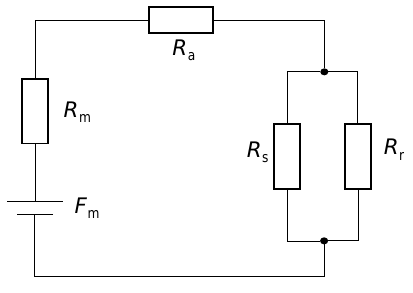
( b ) Figure 12. Effect of changing ring thickness ( N = 30,000 rpm, P o = 500 W): ( a ) torque constant and magnet eddy current loss and ( b ) motor efficiency. ( a ) ( b ) Figure 13. Effect of changing ring relative permeability ( N = 30,000 rpm, P o = 500 W): ( a ) torque constant and magnet eddy current loss and ( b ) motor efficiency. 4.2. Magnteic Circuit The simulation results in Section 4.1 are analyzed by comparing them with the magnetic circuit of the motor. Figure 14 shows a magnetic circuit of a magnetic ring motor. R m , R a , R r , and R s denote the reluctance of the magnet, the air gap, the ring, and the stator core, respectively. Although the cross-sectional area through which magnetic flux passes differs between the teeth and yoke of the